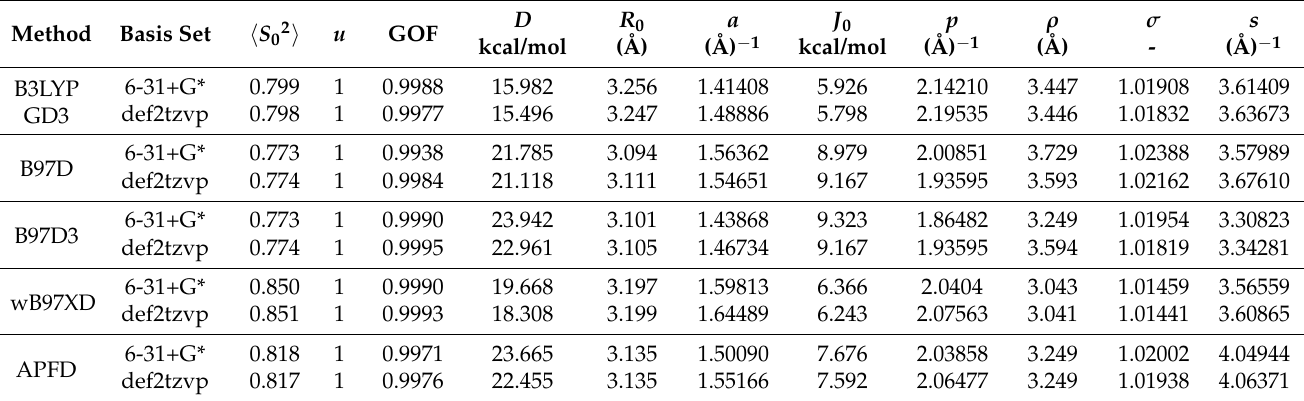
Table 3. Bonding and spin Hamiltonian parameters from handling data from DFT calculations incremented with built-in dispersion addons. The meaning of the quantities is the same as in Table